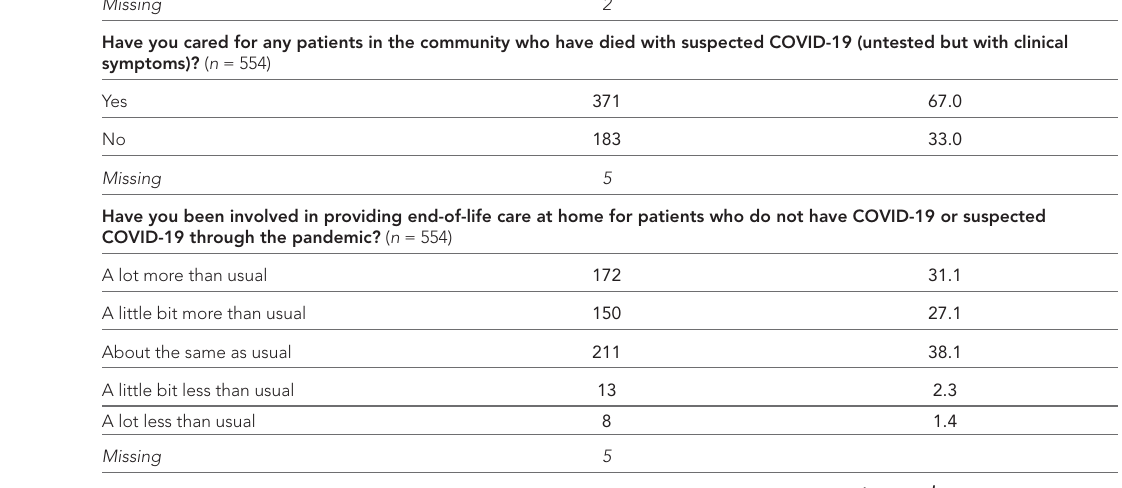
Table 1 Demographic details of responders and information about provision of care for dying pa- tients during the pandemic ( n = 559) Which country do you work in? ( n =